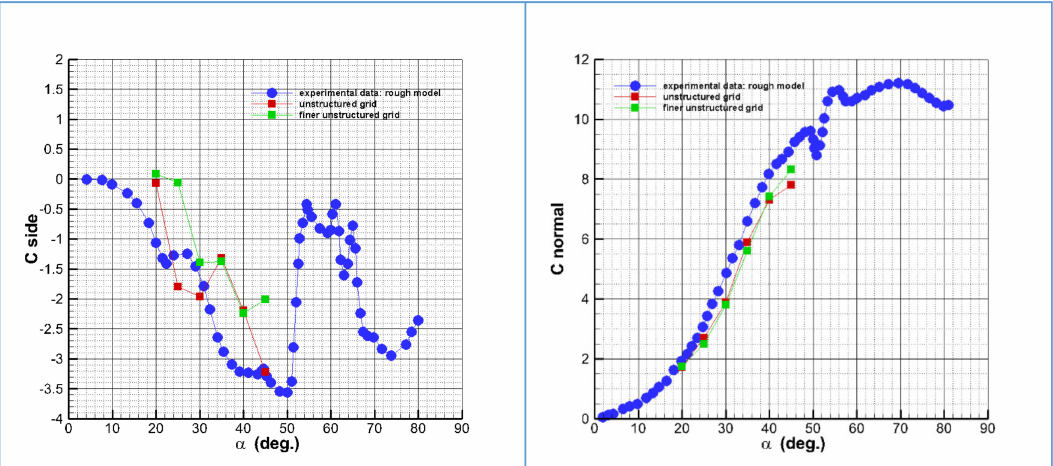
Figure 14. ( Left ) side force coefficient versus angle of attack. ( Right ) normal force coefficient versus angle of attack. Ma = 0.2, Re = 2 × 10 6 . Grid U1 solutions (red squares), Grid U2 solutions (green squares) compared to experimental data (in blue dots) for the rough model.